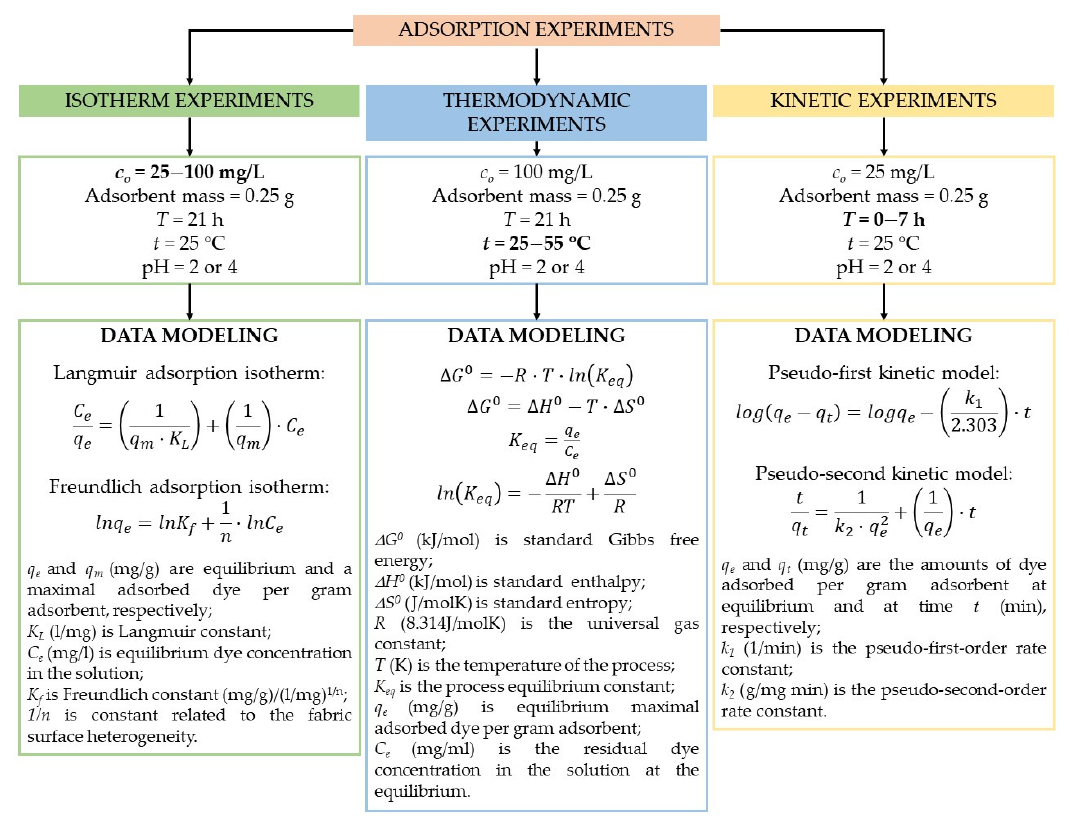
Figure 2. Schematic representation of adsorption experiments and modeling of the obtained data.